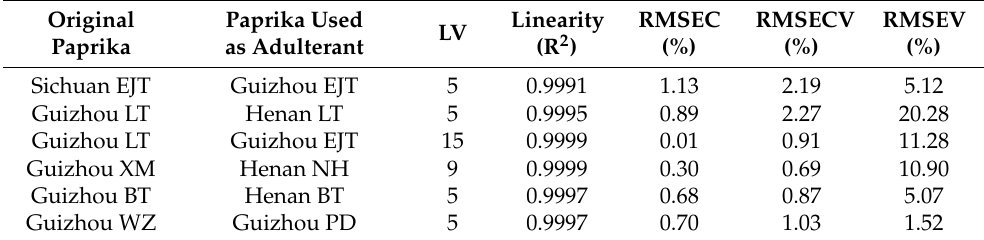
Figure 4. The plots of predicted adulteration levels versus real values obtained by N-PLS regression for six adulteration cases ( a – f ). Table 2. Results for the quantitation of adulteration levels in six cases using second-order HPLC-FLD fingerprints and